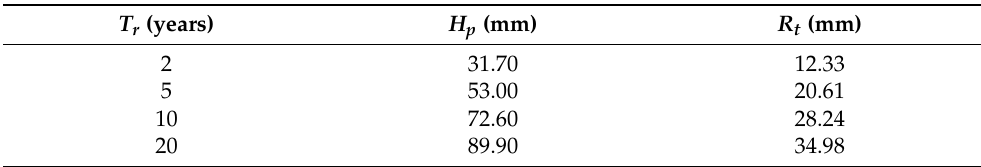
Table 3. Maximum rainfall in 24 h ( H p ) and rainfall ( R t ) for the time of concentration and different return periods ( T r ).